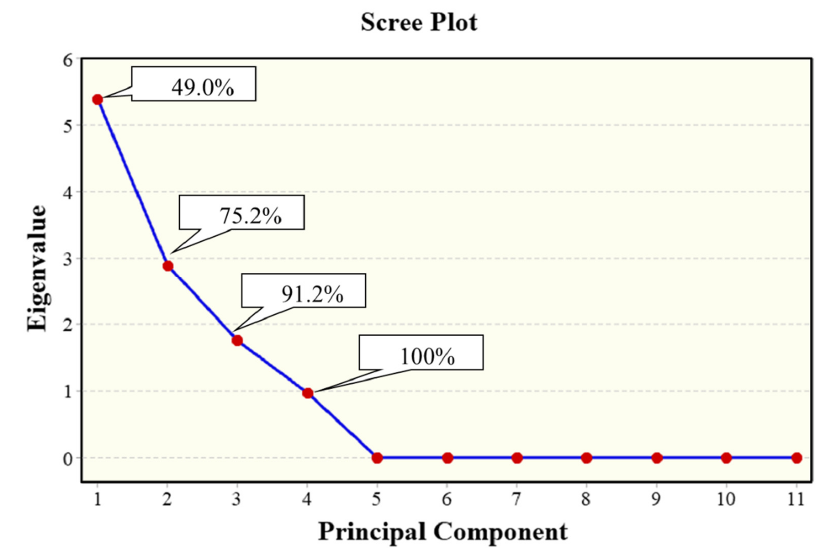
Figure 3. Scree plot of eigenvalues and cumulative variance of principal components from the correlation matrix. Table 5. Eigenvectors defining the linear combination of variables (11 major weeds) and principal components from the correlation matrix (PC5‒PC11 were insignificant). The variables with the largest influence for each principal component are in bold.